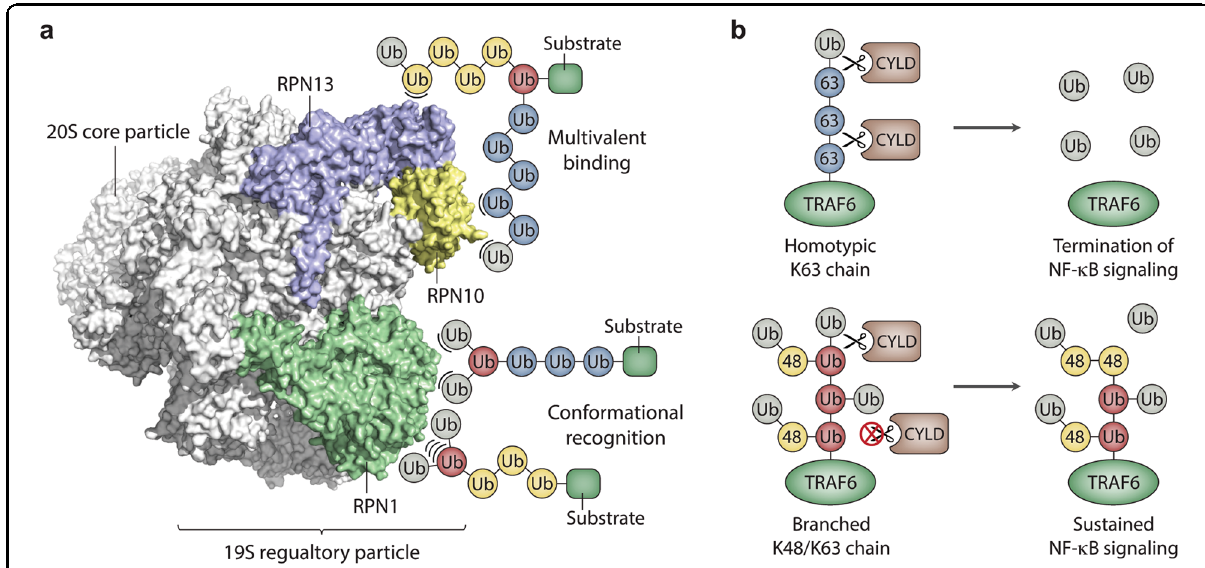
Fig. 3 Models for the recognition and functions of branched ubiquitin chains. a The binding of branched chains to the proteasome (PDB ID: 5T0J) is illustrated schematically. The ubiquitin-binding subunits of the 19S regulatory particle are colored in blue, yellow, and green; all other proteasome subunits are colored in white. The enhanced binding of branched chains to the proteasome as a result of an increase in the local concentration or “ density ” of ubiquitin subunits surrounding the substrate is illustrated by the multivalent-binding model. Enhanced binding due to the recognition of novel interaction surfaces created by branching or recognition of the branch point itself is represented by the conformational recognition model. Non-covalent interactions between ubiquitin and proteasome subunits are represented by arcs. The positions of the ubiquitin- binding sites on the proteasome are shown for schematic purposes only. b Model for the role of branched K48/K63 chains in the activation of NF- κ B signaling. Homotypic K63-linked chains are ef fi ciently disassembled by CYLD, resulting in the removal of K63 linkages from TRAF6 and the termination of NF- κ B signaling (top). Branched K48/K63 chains are resistant to CYLD cleavage, resulting in the persistence of K63 linkages on TRAF6 and sustained activation of NF- κ B signaling (bottom). Branched ubiquitin subunits modi fi ed at both K48 and K63 are colored in